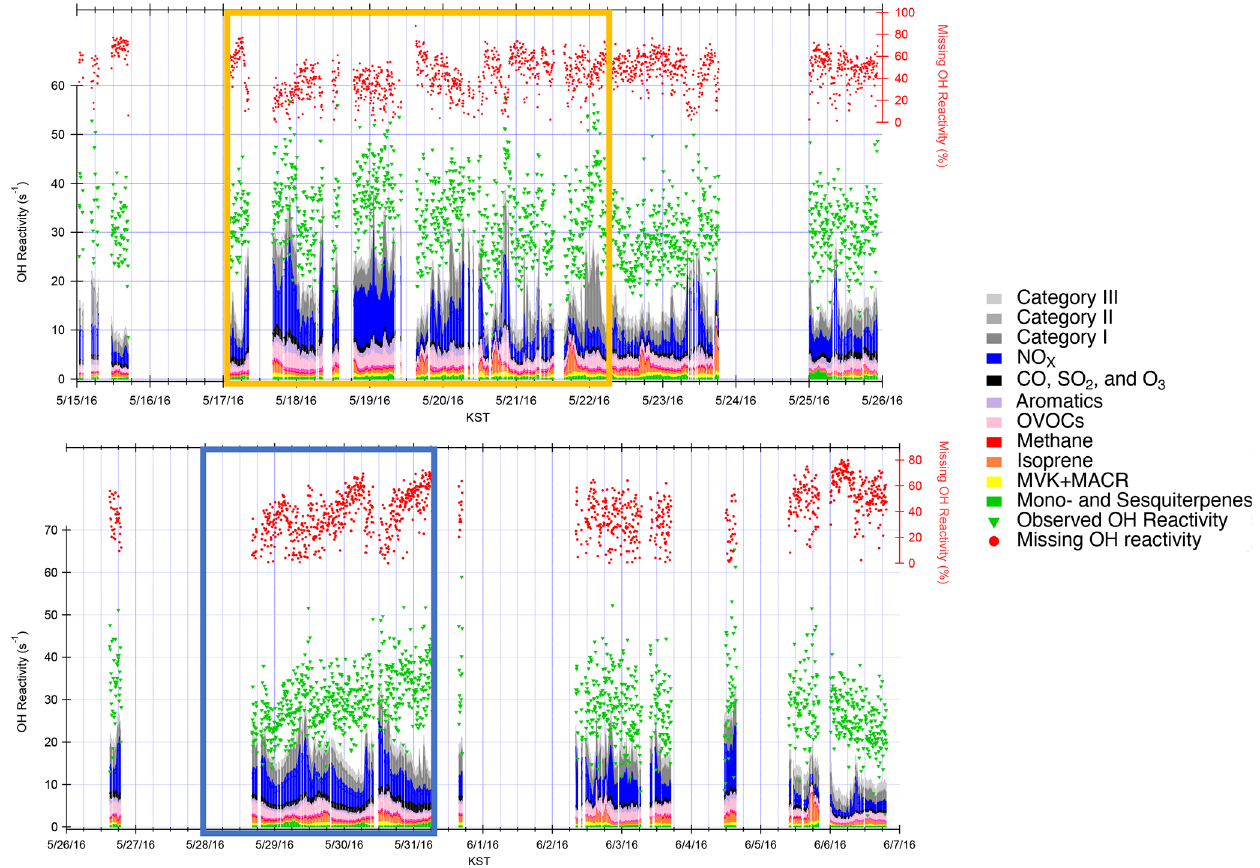
Figure 1. Observed and calculated OH reactivity during KORUS-AQ 2016. The measured and calculated OH reactivity are on the left axis, while the missing OH reactivity is on the right axis. The yellow box represents the stagnation period, and the blue box represents the transport period.